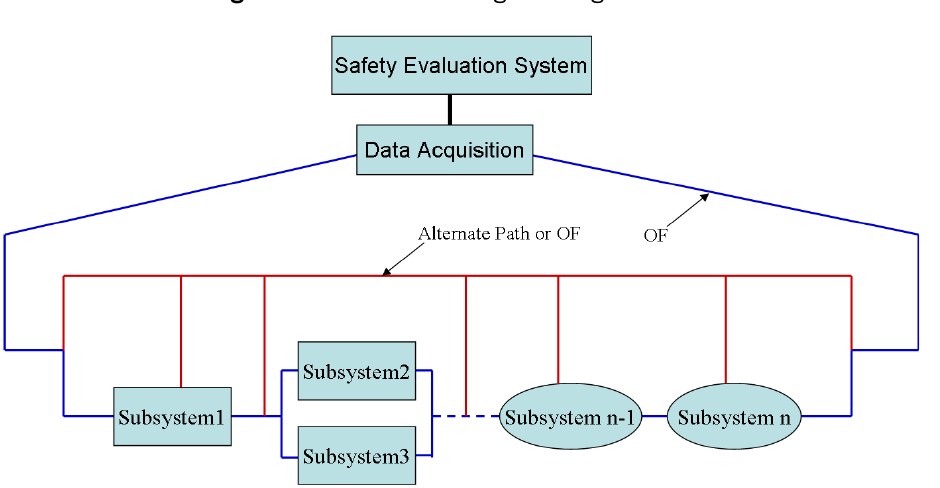
Figure 16. A self-healing sensing network.